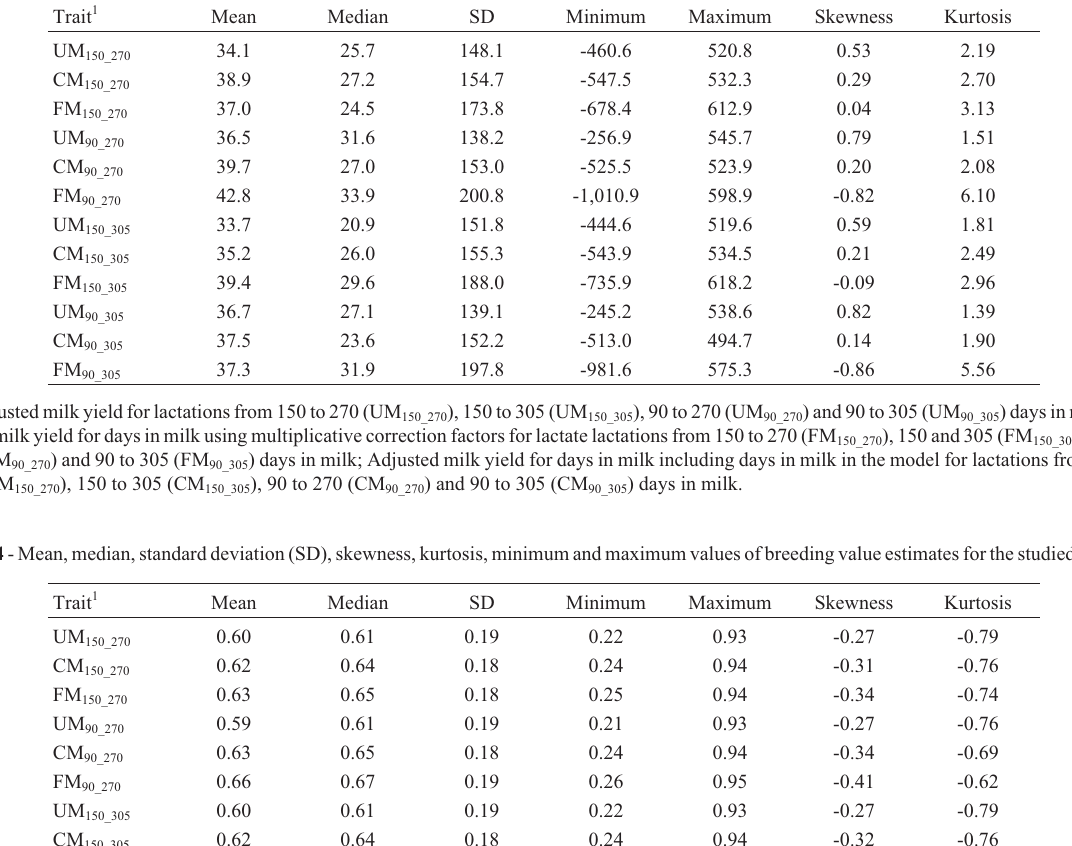
Table3 -Mean,median,standarddeviation(SD),skewness,kurtosis,minimumandmaximumvaluesofbreedingvalueestimatesforthestudiedtraits. Trait 1